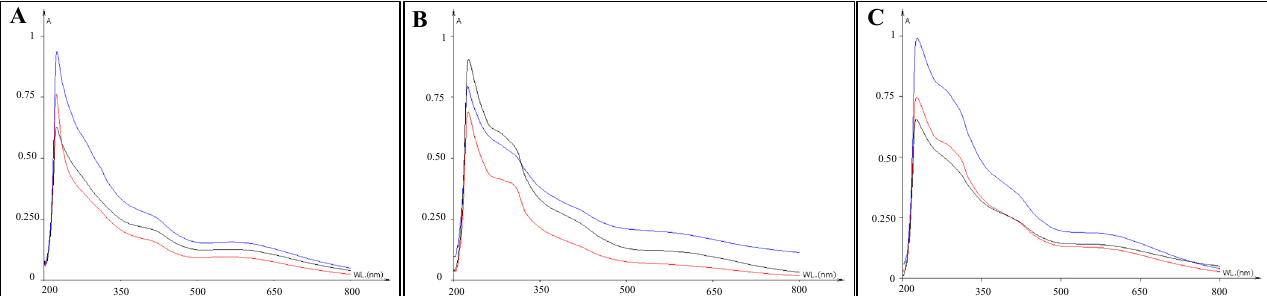
Figure 1. UV–VIS-spectra of melanin pigment extracted from C. antarcticus colonies grown on ( A ) OS exposed to simulated space conditions; ( B ) P-MRS and ( C ) S-MRS exposed to Mars-like conditions on different layers: Top (exposed to sun light with 0.1% Neutral Density filters) = red spectrum, Bottom (dark control in space, not exposed to space radiation) = blue spectrum and CTR (sample kept in the lab, in the dark at room temperature) = black spectrum. OS = Original Substrate, P-MRS = Phyllosilicatic Mars Regolith Simulant, S-MRS = Sulfatic Mars Regolith Simulant.